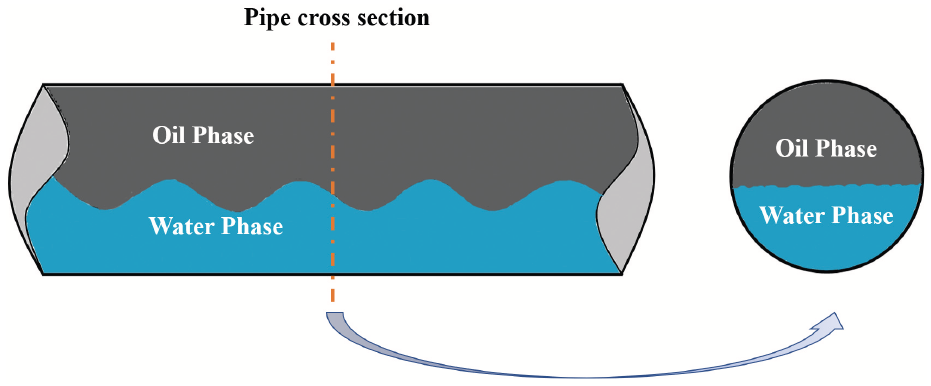
Figure 1. Schematic of oil–water stratified pipe